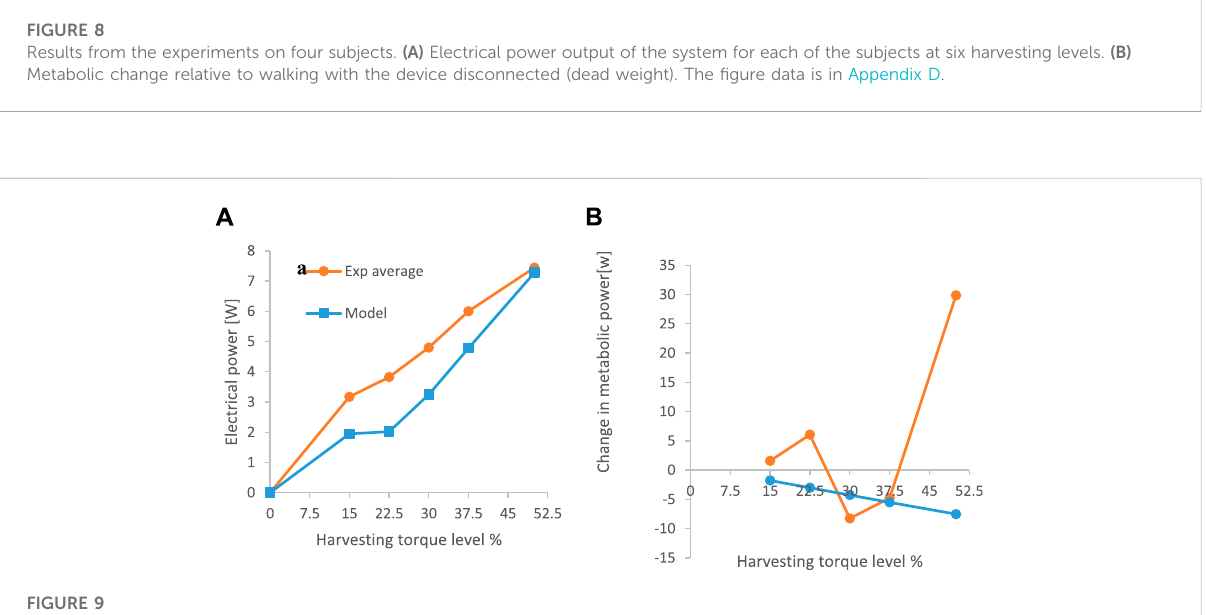
FIGURE 9 Comparison between the average results from the experiment and the predictions of the simulation. (A) electrical power harvested. (B) metabolic